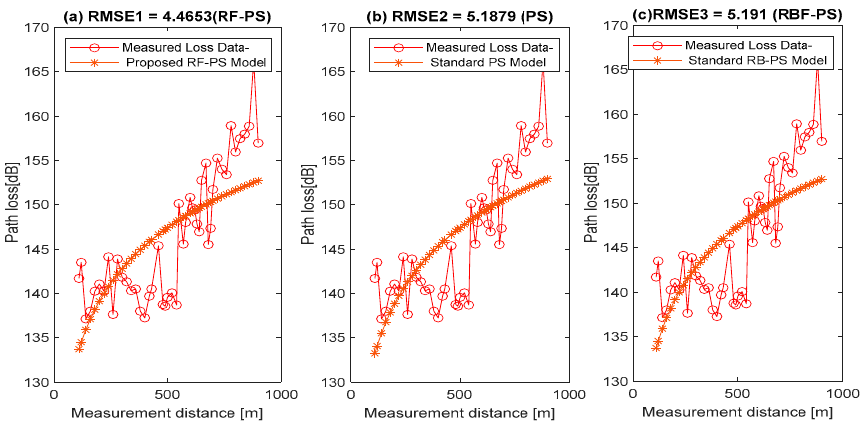
Figure 19. Results showing the measured path loss versus distance using the hybrid RF-PS method and two existing standard path loss prediction methods in site 3 of location 4.